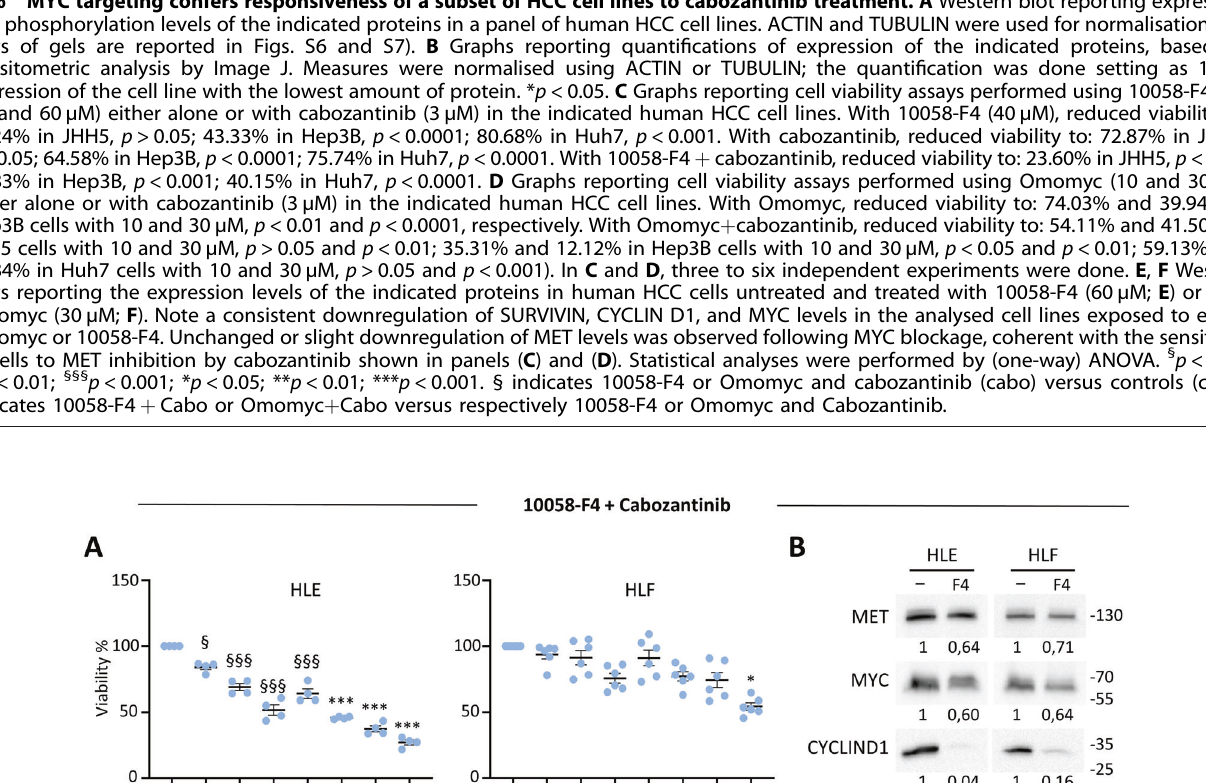
Fig. 7 MYC targeting sensitises HCC cell lines belonging to the CL3 subgroup to cabozantinib treatment. A Graphs reporting data of cell viability assays performed using 10058-F4 (20, 40, and 60 µM) either alone or with cabozantinib (3 µM) for 72h in HLE and HLF human HCC cell lines. 10058-F4 (60µM) reduced viability to: 51.77% in HLE, p < 0.0001; 75.62% in HLF, p <0.01. Cabozantinib reduced viability to: 64.01% in HLE, p <0.0001; 91.11% in HLF, p >0.05. 10058-F4 + cabozantinib reduced viability to: 27.20% in HLE, p <0.0001; 54.31% in HLF, p <0.05. B Western blots reporting the expression levels of the indicated proteins in human HCC cells untreated and treated with 10058-F4 (60 µM). Note a consistent downregulation of SURVIVIN, CYCLIN D1, and a partial reduction of MYC levels in HLE and HLF exposed to 10058-F4. Slight downregulation of MET levels was observed following MYC blockage, supporting the sensitivity of cells to MET inhibition by cabozantinib shown in panel ( A ). Statistical analyses were performed by (one-way) ANOVA. § p <0.05; §§ p <0.01; §§§ p <0.001; * p < 0.05; ** p < 0.01; *** p < 0.001. § indicates 10058-F4 and cabozantinib (cabo) versus controls (ctr); * indicates 10058-F4 + Cabo versus respectively 10058-F4 and